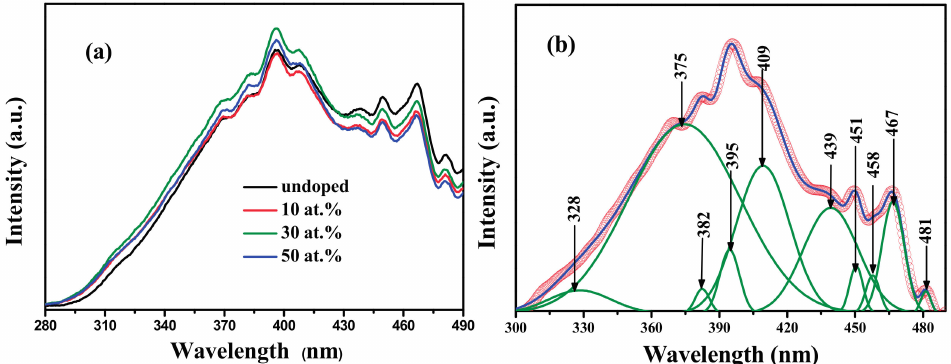
Figure 7. ( a ) Room temperature PL spectra of SnO 2 and FTO NPs annealed; ( b ) Gaussian deconvoluted PL spectrum of FTO NPs with 50 at. % F doping.